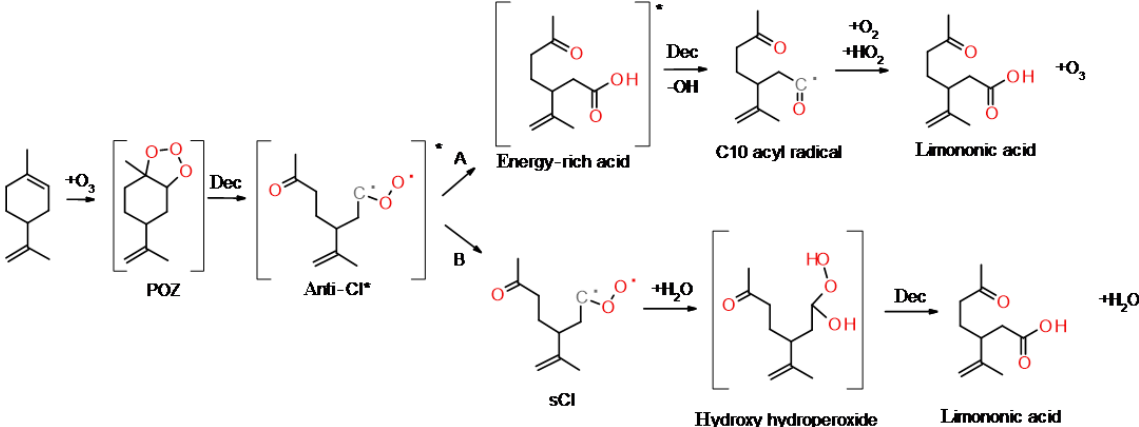
Figure 1. (a) Example of the initial reactions of limonene with ozone to form limononic acid from the anti-CI ∗ via the hot acid channel and (b) the collisional stabilisation channel (Vereecken and Francisco,